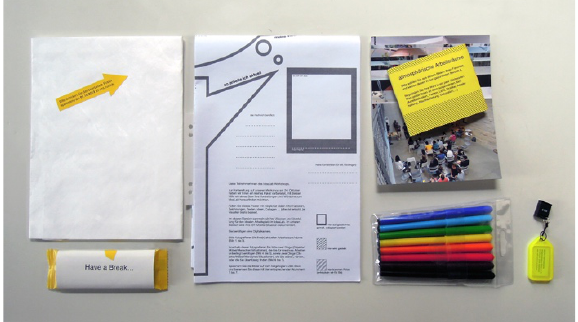
Fig. 2. Overview of cultural probes set. Contents: canvas poster, pictures of exemplary creative spaces, coloured pens, snack with questionnaire inside, USB stick for digital files, and return